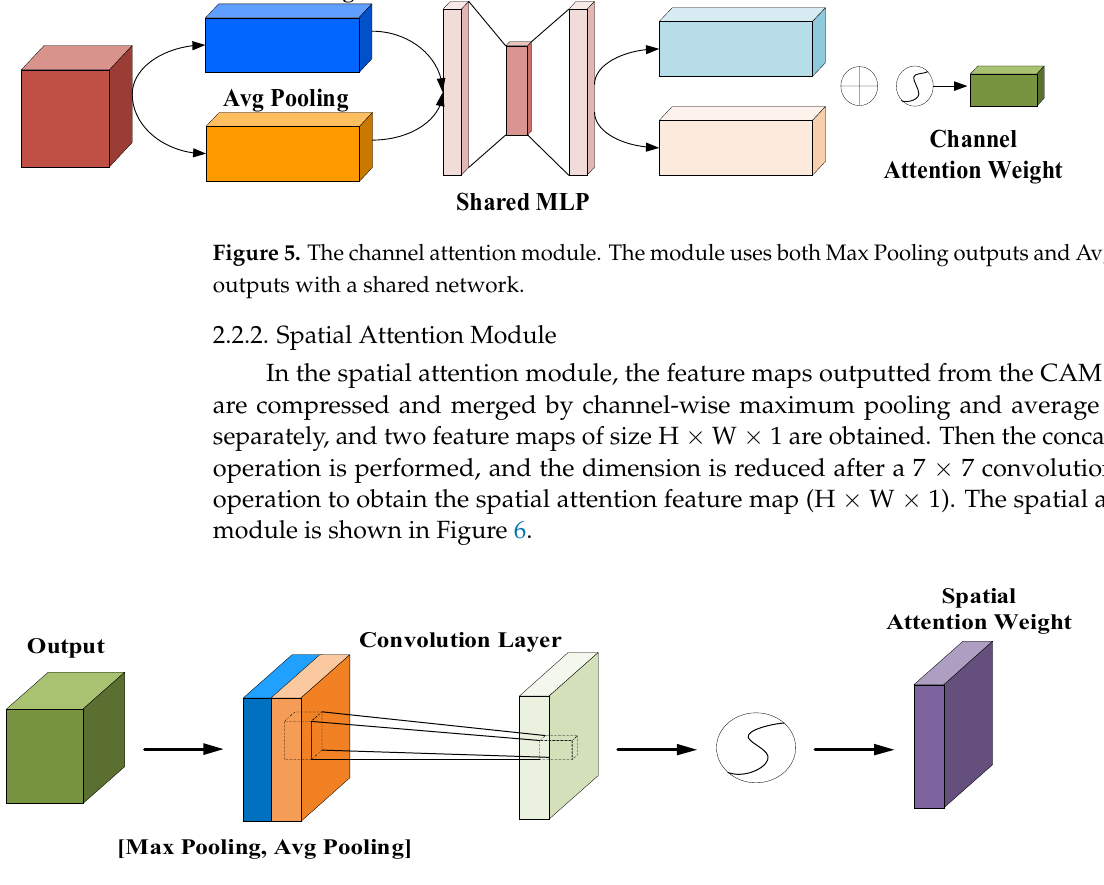
Figure 6. The spatial attention module. The module uses two outputs from Max Pooling and Avg Pooling which are pooled along the channel axis and passes them to a convolution layer.